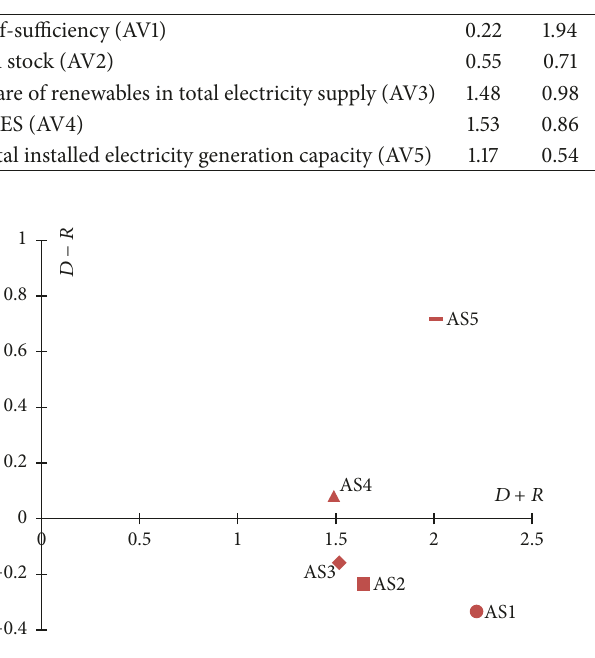
Figure 7: Cause-effect relationship diagram for Accessibility (Case 2 ).